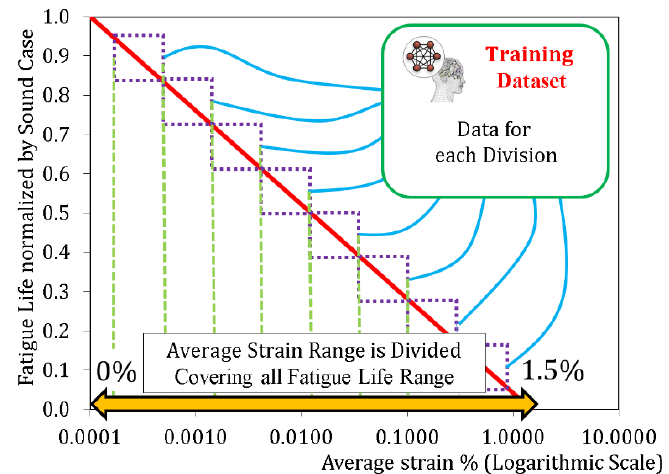
Figure 8. Strategy of the training dataset.